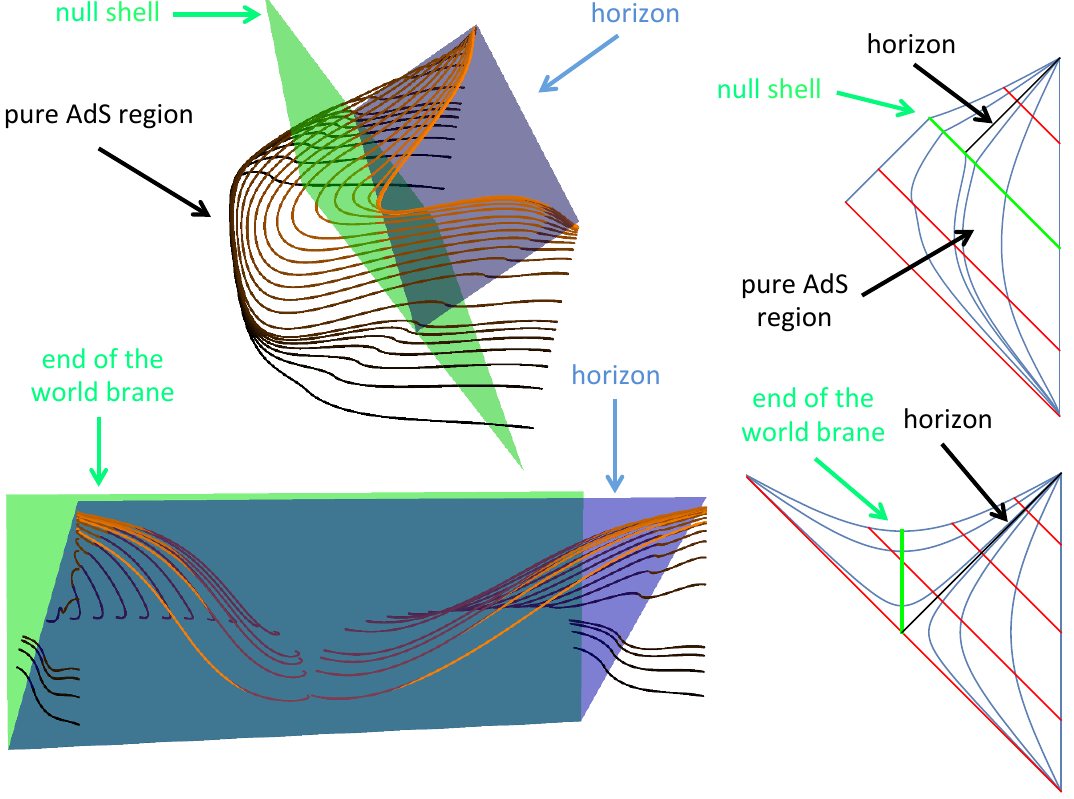
Figure 5. HRT surfaces with R = 4 in the Schwarzschild geometry corresponding to d = 3 boundary dimensions. On the left we plotted the HRT surfaces ( v ( (cid:26) ) ; z ( (cid:26) )) in coordinates that correspond to the Penrose diagram shown on the right. On the right only the part of the Penrose diagram is shown that is covered by the coordinates ( z; v ). Top: HRT surfaces in the Vaidya setup, with the null shell shown with green and the horizon with blue. Darker color correspond to earlier times. At very early times, much of the surface is in the pure AdS region, and is an almost perfect hemisphere in the coordinates (2.1), deformed by the conformal mapping that gives the Penrose diagram on the right. As time evolves the surface goes behind the horizon, most of it lies on z HM , and near saturation it climbs out from behind the horizon and the entropy saturates, when the surface is only barely touching the shell. Bottom: HRT surfaces in the end of the world brane setup. At early times the HRT surface is a tube connecting the boundary theory entangling surface (cid:6) to the brane, and the image on the brane is (cid:6) im (cid:6). The linear regime of entropy growth takes (cid:25) place, when (cid:6) im migrates up to z HM . We can clearly see that as we go to later times (lighter color) (cid:6) im is shrinking, but staying at z HM . Finally (cid:6) im migrates towards the bifurcation surface, but this is an O ( (cid:12)=R ) e(cid:11)ect. For similar (cid:12)gures, see [40].